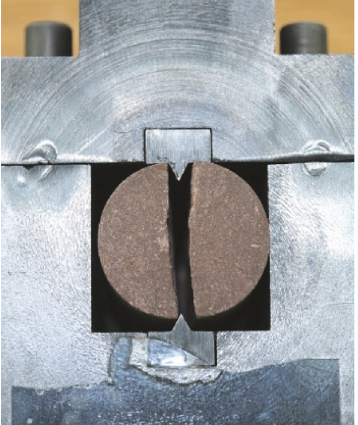
Figure 4: Device for splitting core sample to generate a